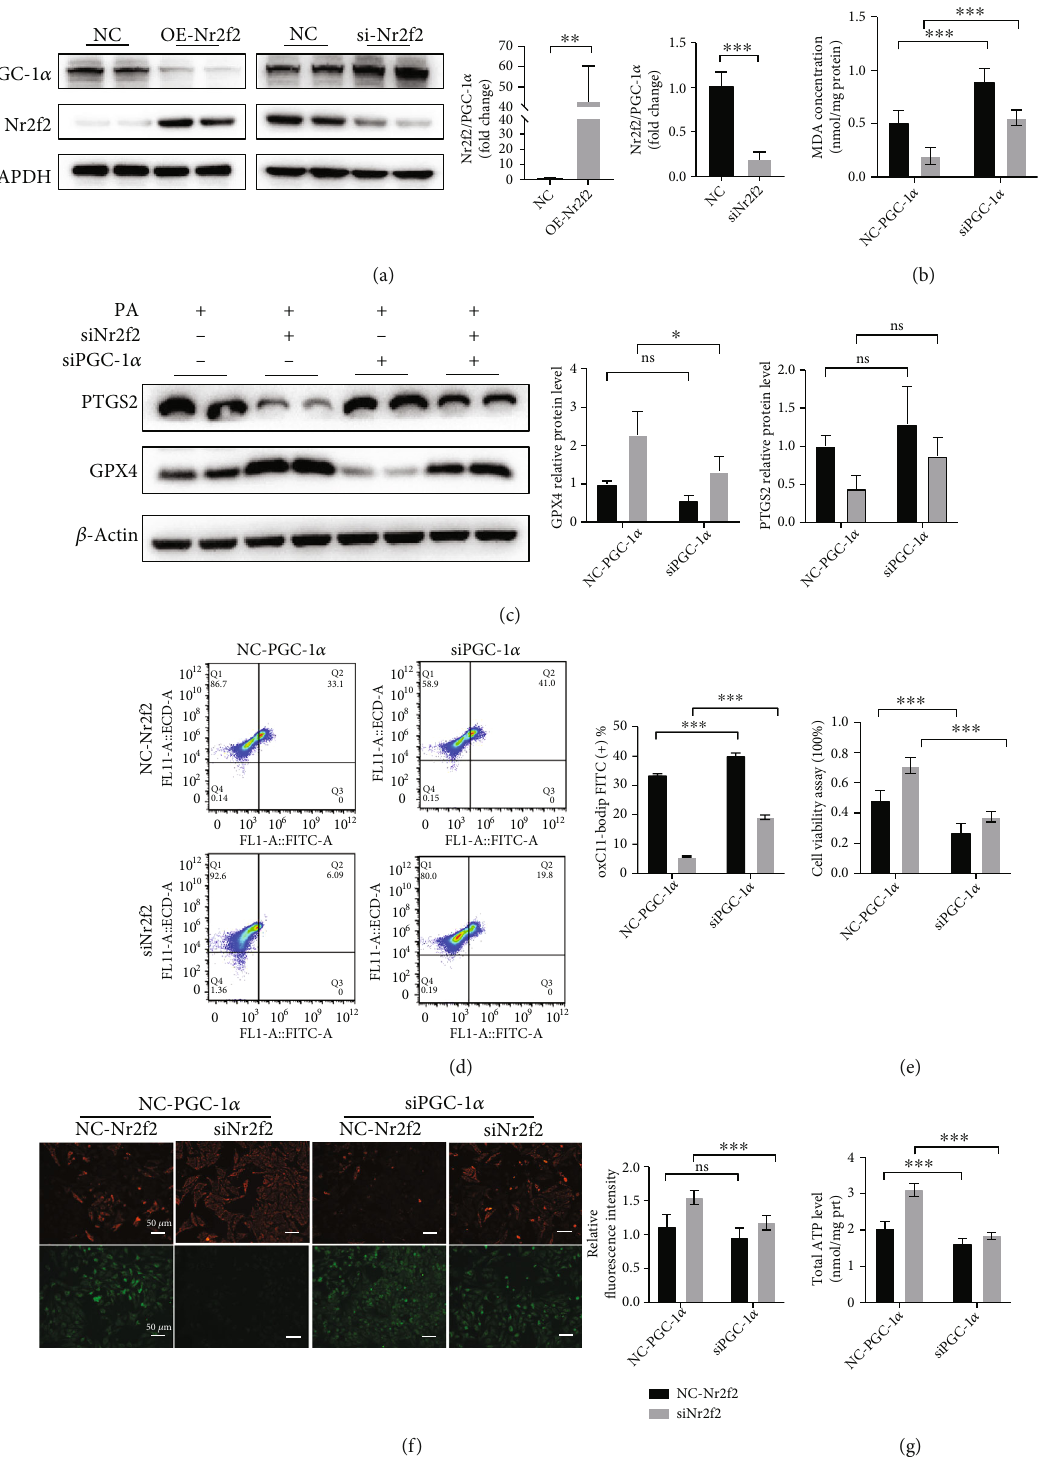
Figure 4: Nr2f2 regulates ferroptosis and mitochondrial dysfunction via PGC-1 α . (a) Representative Western blot of the PGC-1 α protein level after Nr2f2 overexpression and knockdown ( n = 4 , means ± SDs , ∗∗ p < 0 : 01 and ∗∗∗ p < 0 : 005 , Student ’ t -test). (b) MDA level in each group ( n = 6 , means ± SDs , ∗∗∗ p < 0 : 005 ; ns: not signi fi cant, two-way ANOVA). (c) Representative Western blot of PTGS2 and GPX4. ( n = 4 , means ± SDs , ∗ p < 0 : 05 and ∗∗ p < 0 : 01 , two-way ANOVA). (d) Lipid ROS was assessed by C11 BODIPY 581/591 staining coupled with fl ow cytometry analysis ( n = 3 , means ± SDs , ∗∗∗ p < 0 : 005 , two-way ANOVA). (e) Cell viability was measured by CCK8 ( n = 6 , means ± SDs , ∗∗∗ p < 0 : 005 , two-way ANOVA). (f) Representative JC-1 staining (scale bar = 50 μ m , n = 6 , means ± SDs ; ns: not signi fi cant, ∗∗∗ p < 0 : 005 , two-way ANOVA). (g) Intracellular ATP level in each group ( n = 6 , means ± SDs , ∗∗∗ p < 0 : 005 , two-way